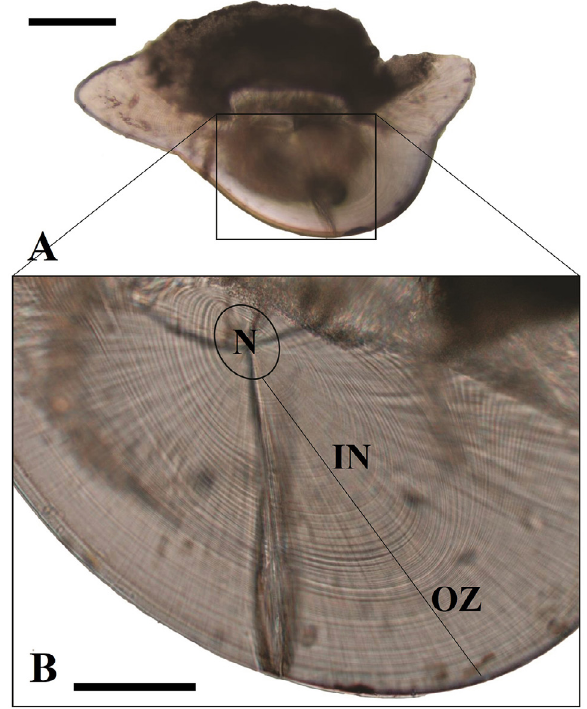
Fig. 3. – Light micrograph of the statolith of Abralia andamanica (DML=38 mm) (A) and lateral dome region of statolith with incre- ments (B). N, nucleus; IN, inner zone; and OZ, outer zone of the statolith (scale bar, A=200 µm; B=100 µm).